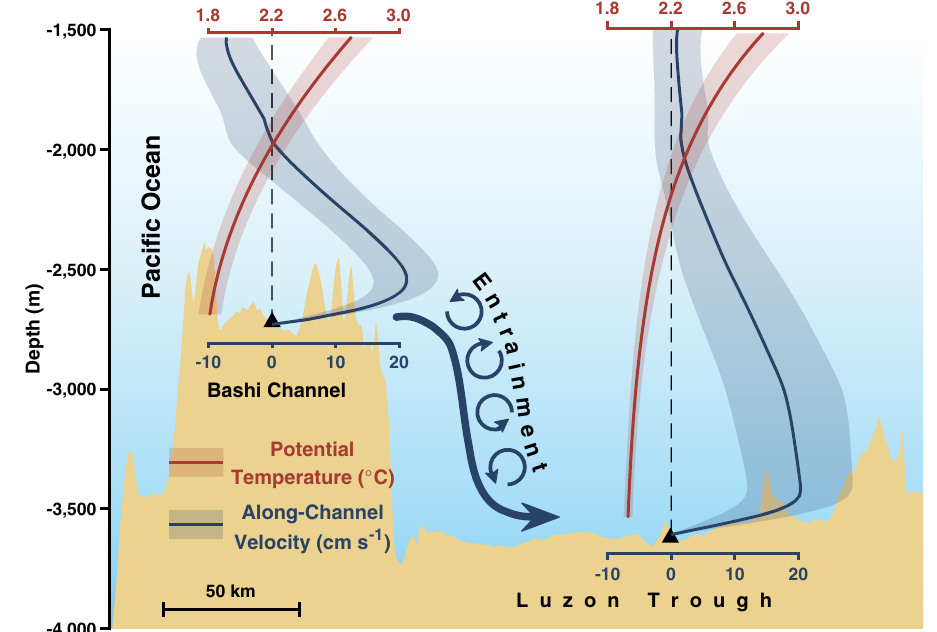
Fig.2|MeanstateoftheLuzonStraitover fl ow. Theverticalpro fi lebelow1500m of the whole-period-mean potential temperature (red) and along-channel velocity (blue) at BC and LT, respectively, with shading showing tide-excluded standard deviation. Positive (negative) velocity indicates that waters fl ow into (out of) the